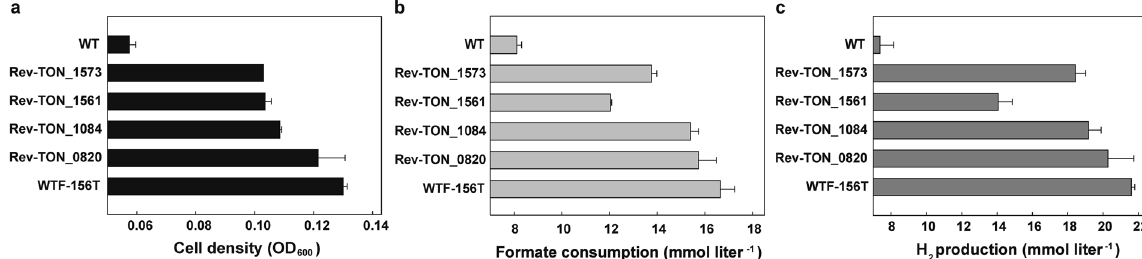
Figure 3. The effect of each mutation was determined by restoring each mutation in the WTF-156T strain. Cell growth ( a ), formate consumption ( b ) and H 2 production ( c ) in the revertants were analysed in comparison with those of the parent and WTF-156T strains at the late exponential phase (after 6 h incubation). Error bars indicate the standard deviation from three independent experiments.